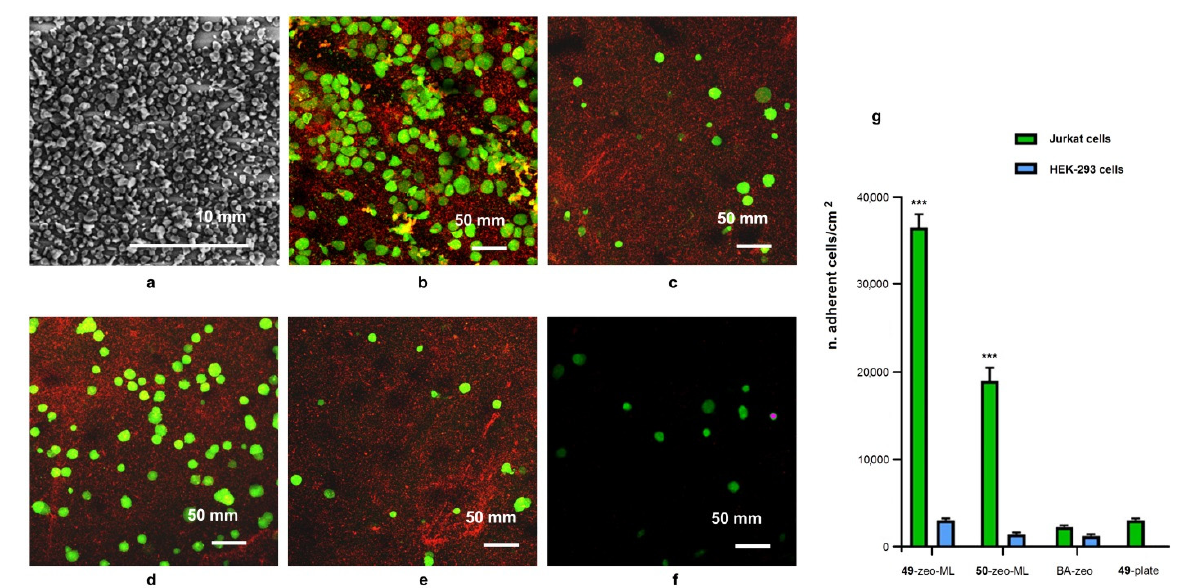
Figure 3. ( a ) SEM image of IC–zeolite ML. Cell adhesion to peptide monolayers: ( b – f ) confocal microscopy images of monolayers after 15 min incubation at 37 °C with 5 × 10 5 cells; ( b ) Jurkat cells adhered to 49 –zeolite ML; ( c ) HEK-293 cells adhered to 49 –zeolite ML ; ( d ) Jurkat cells on 50 –zeolite ML; ( e ) Jurkat cells on BA–zeolite ML; ( f ) Jurkat cells on 49 -plate; ( g ) Number of adhered cells/cm 2 (analyzed area: 0.0025 cm 2 ); data are shown as mean ± SD of three independent experiments. *** p < 0.001 vs. HEK-293 seeded onto peptide-zolite ML. Cells are visualized in green, while zeolites are visualized in red.